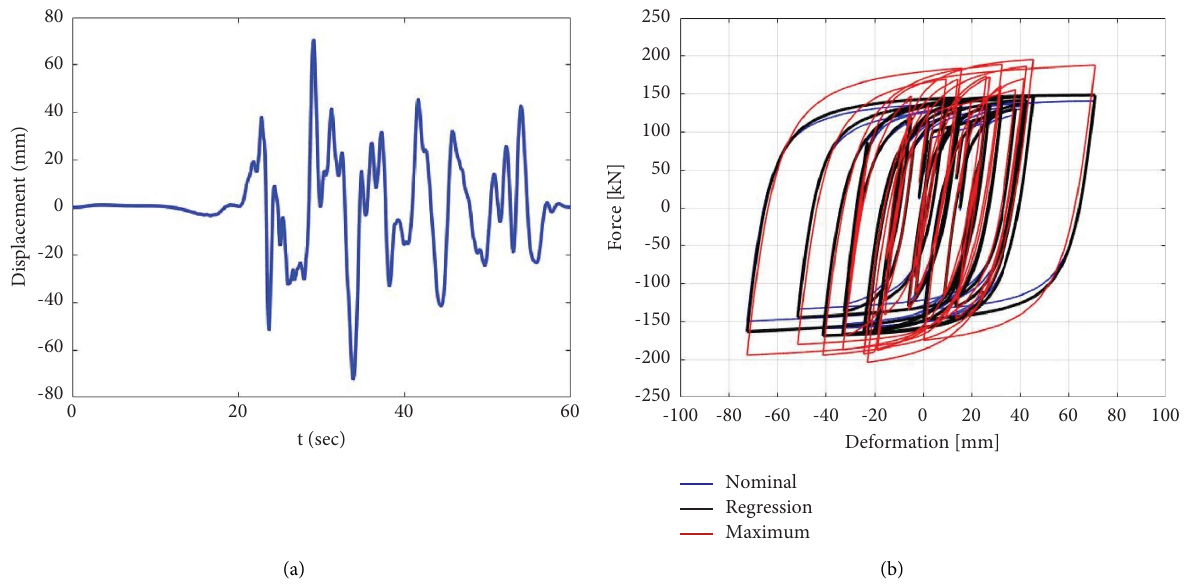
Figure 10: ID4840: applied displacements (a) and hysteresis curves (b).